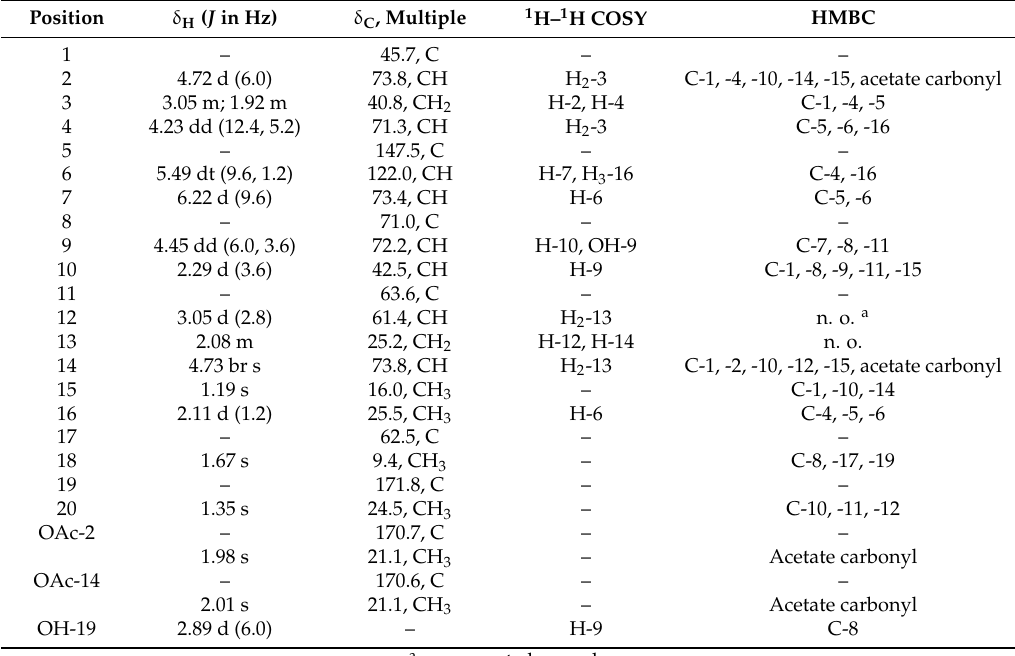
Table 3. 1 H (400 MHz, CDCl 3 ) and 13 C (100 MHz, CDCl 3 ) NMR data and 1 H– 1 H COSY and HMBC correlations for briarane 3